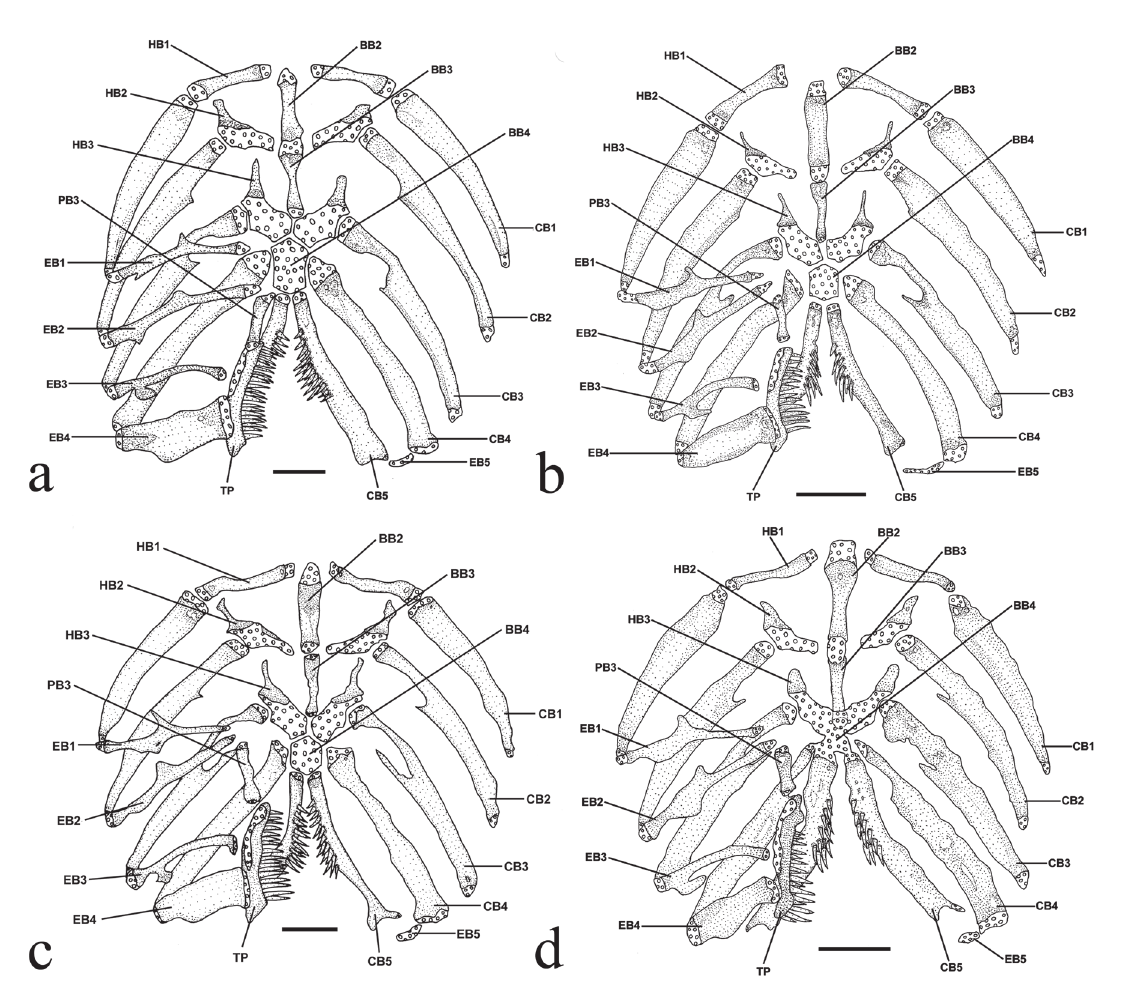
Fig. 3. Dorsal view of gill arches (right dorsal elements and gill rakers not show) of ( a ) Trichomycterus balios , paratype, UFRGS 6831, 81.7 mm SL; ( b ) T . diatropoporos , paratype, UFRGS 16237, 57.8 mm SL; ( c ) T . poikilos , paratype, MCP 22699, 79.0 mm SL; and ( d ) T . brachykechenos , paratype, UFRGS 16244, 51.6 mm SL. Abbreviations: BB2-4, basibranchials 2 to 4; CB1-5, ceratobranchials 1 to 5; EB1-5, epibranchials 1 to 5; HB1-3, hypobranchials 1 to 3; PB3, pharyngobranchial 3; TP; tooth plate. Scale bar = 1